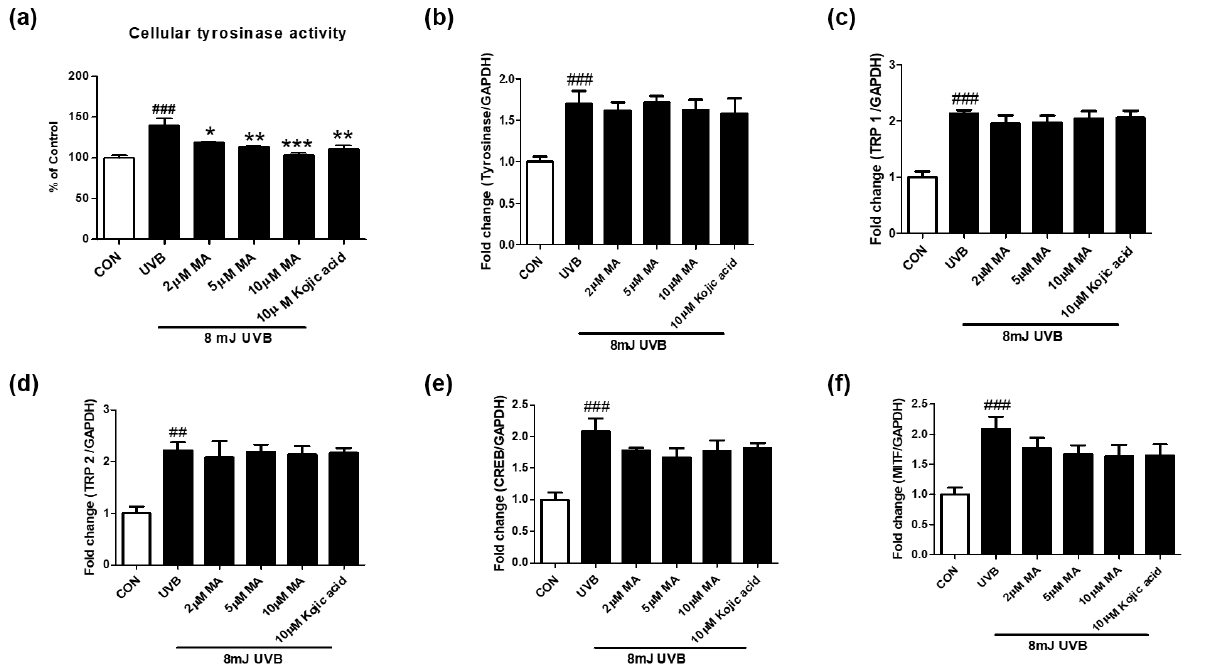
Figure 3. Maclurin suppressed cellular tyrosinase activity without altering mRNA levels of genes related to melanogenesis. ( a ) Cellular tyrosinase activity was measured using B16F10 cells after the pretreatment of maclurin for 1 h followed by UVB exposure (8 mJ). QPCR was performed to measure mRNA levels of ( b ) tyrosinase, ( c ) TRP1, ( d ) TRP2, ( e ) CREB, and ( f ) MITF. All data represented the mean ± SEM at least three times. ## p < 0.01, ### p < 0.001 compared with the non-exposed control group and * p < 0.05, ** p < 0.01, and *** p < 0.001 compared to the UVB-exposed group.